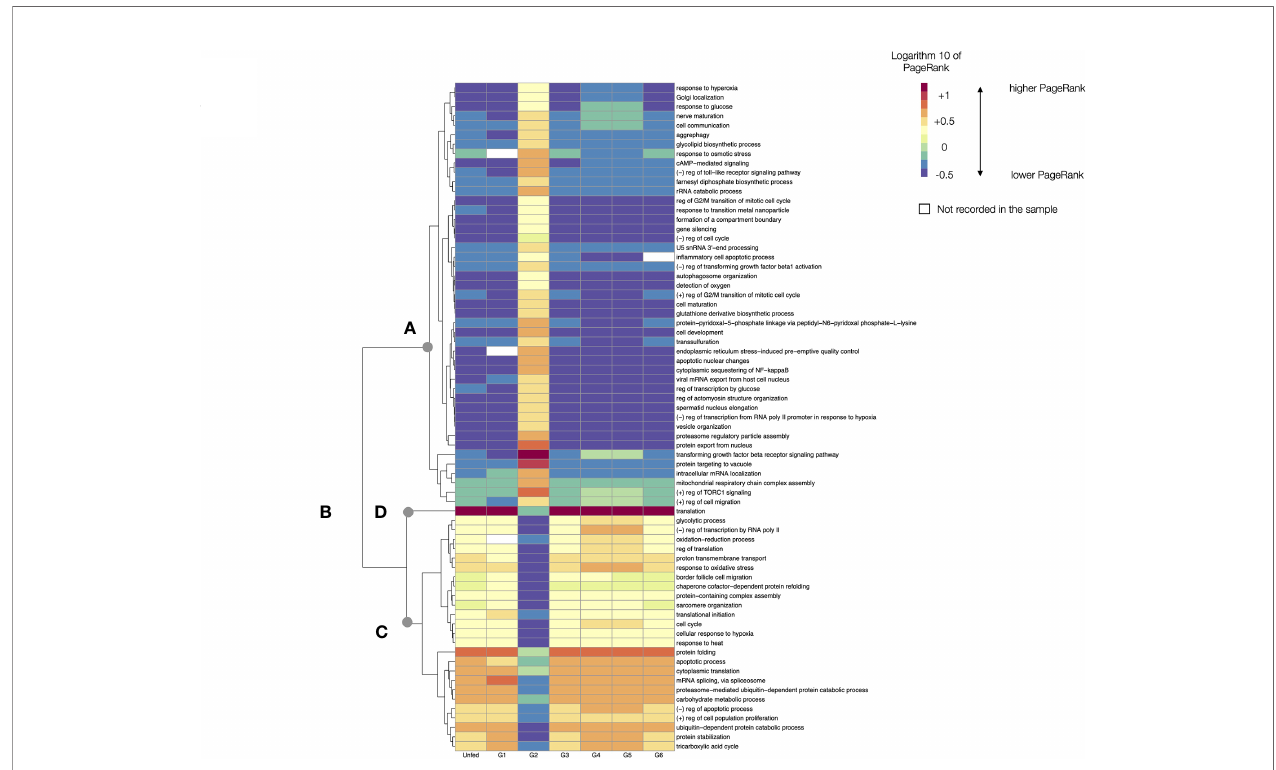
FIGURE 5 | A heatmap displaying the values of the log10 of PageRank of the low-level processes in unfed and feeding R. sanguineus. The chart displays only the processes with a rate of change located in the top percentile 98% of variability (i.e., only the 2% of processes, those with highest variability, are shown). The heatmap shows the processes grouped according to a dendrogram (left) grouping those processes with similar patterns of variability. Dots labelled (A – D) show breaking points of the dendrogram, intended only as a help for interpretation. The tick group (unfed, G1 to G6) is included at the bottom of the fi gure, following the terminology of the original data by Tirloni et al. (2020). The name of the LL process is at right of the chart. In the legend, the symbol “ + ” denotes “ positive ” and the symbol “ - ” denotes negative. Cells in white are absent